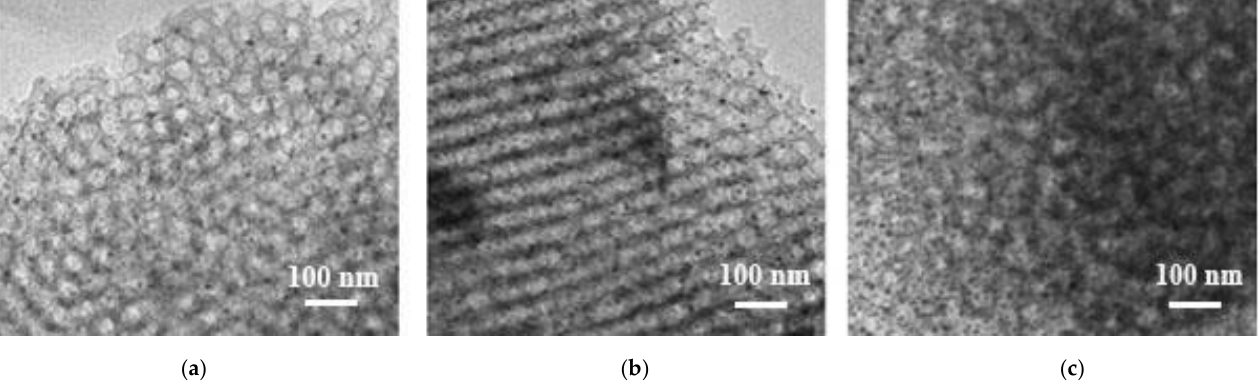
Figure 3. The TEM patterns of the nanocomposites with different cobalt precursor/resol ratio treated under N 2 atmosphere at 600 °C: ( a ) CoO x /C-0.1; ( b ) CoO x /C-0.2; ( c ) CoO x /C-0.3.